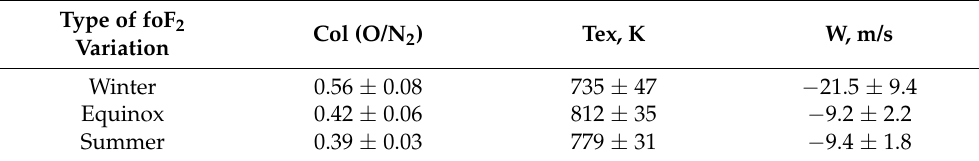
Table 1. Average along with ± SD retrieved at Juliusruh col(O/N 2 ), Tex, and W over the dates with three types of foF 2 diurnal